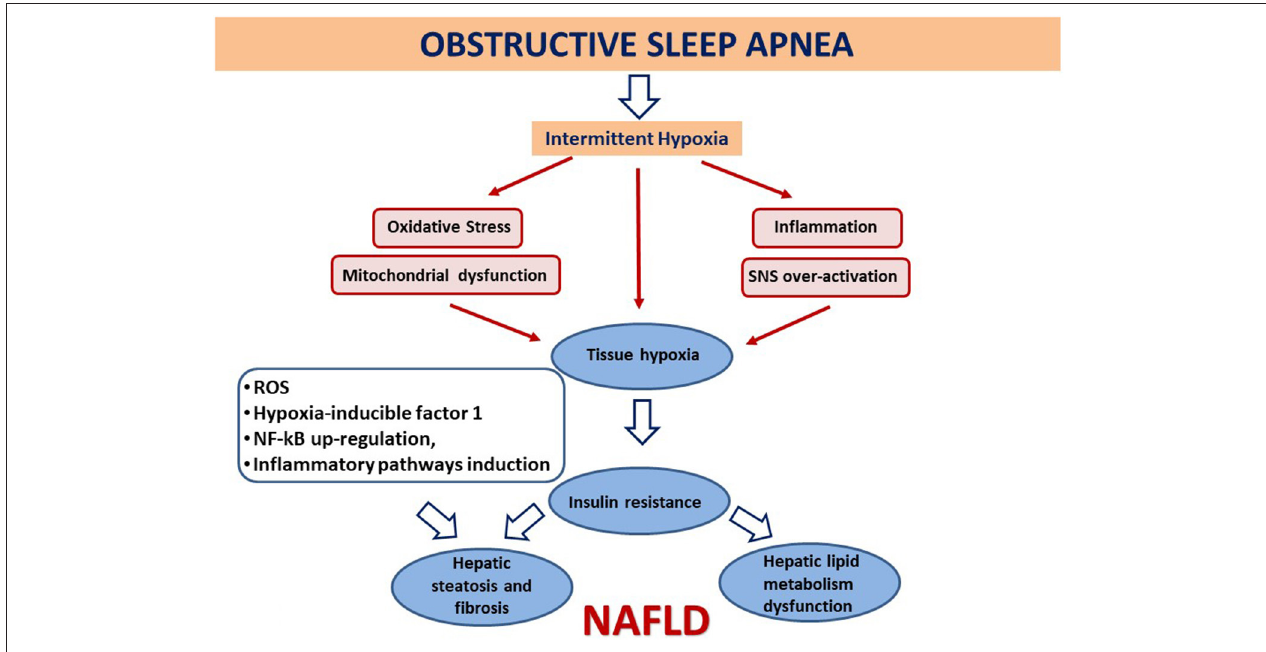
FIGURE 2 | Association between obstructive sleep apnea and the development and evolution of non-alcoholic fatty liver disease. Intermittent hypoxia leads to tissue hypoxia, OS, mitochondrial dysfunction, inflammation, and overactivation of the sympathetic nervous system (SNS). Generated reactive O 2 species (ROS) may amplify liver injury by activating hypoxia-inducible factor 1, a transcriptional activator and master regulator of O 2 homeostasis during hypoxia, and by up-regulating nuclear factor κ -light-chain enhancer of activated B cells (NF- κ B), with subsequent downstream induction of inflammatory pathways. As a consequence, this involves insulin resistance, dysfunction of key steps in hepatic lipid metabolism, atherosclerosis, and hepatic steatosis and fibrosis, each of which is pertinent to the development and/or progression of non-alcoholic fatty liver disease (NAFLD) ( 98–101).